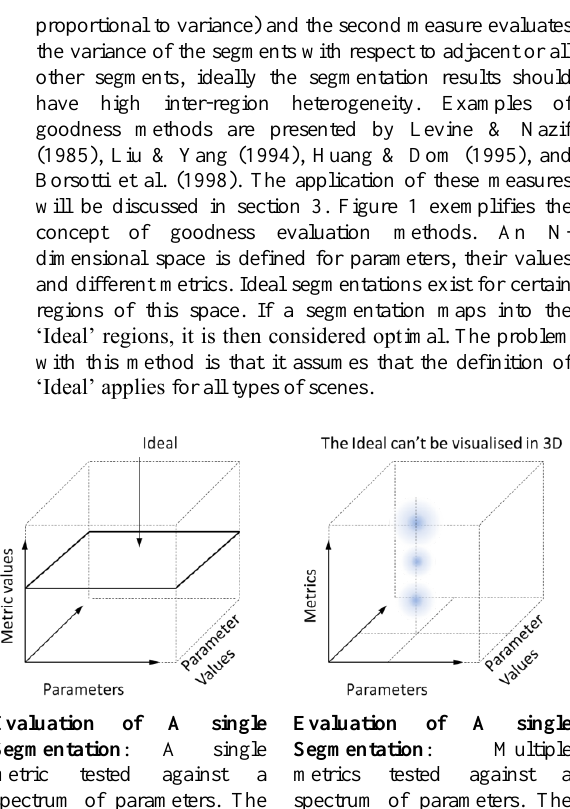
Figure 1 Goodness Methods, two possible variations.